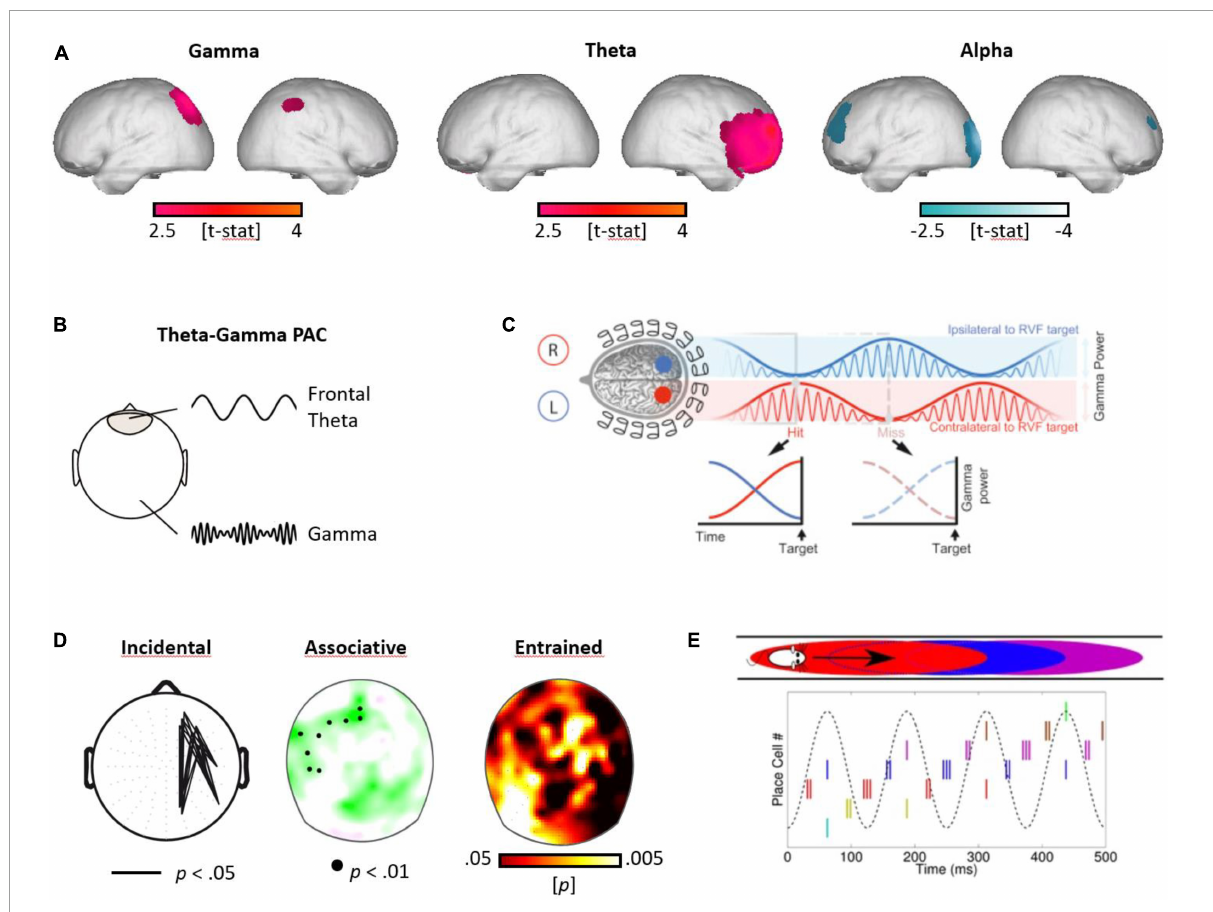
FIGURE3 Gamma, theta, and alpha oscillations in human attention, memory, and prediction. (A) Gamma, theta, and alpha oscillations during encoding. Subsequently remembered (in contrast to forgotten) items elicited higher parietal gamma, frontal theta, and reduced alpha power in frontal and parietal networks (modified from Friese et al., 2013). (B) The concept of phase-to-amplitude coupling (PAC) between the frontal theta rhythm and cortical gamma oscillations. (C) Attentional sampling. The modulation of attention, alternating between perceptual target locations in the left and right visual field, with the theta-modulated gamma amplitude predicting the detection of a specific target [cf. Landau et al., 2015; (reproduced with permission)]. (D) Memonic updating. Theta-gamma coupling was accentuated for subsequently remembered items in an incidental (Friese et al., 2013) and an associative memory task (Köster et al., 2018), as well as during enhanced encoding for visual perceptual entrainment at the theta rhythm (Köster et al., 2019b). (E) Predictive coding. Visualization of the predictive processes during a spatial paradigm, as characterized in mice (O’Keefe and Recce, 1993). The firing of place cells, encoding different locations in a labyrinth, fire at specific phases of the theta rhythm, in a sequential manner, before the mouse enters a specific location (graph from Chadwick et al., 2015;